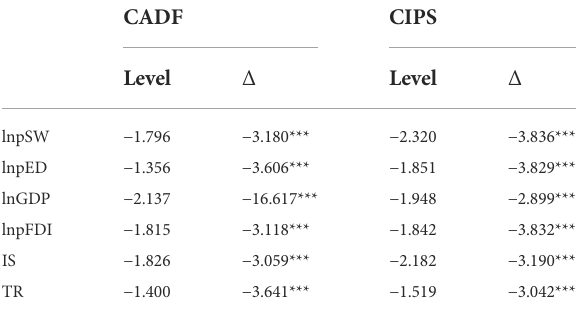
TABLE 7 Results from panel unit root